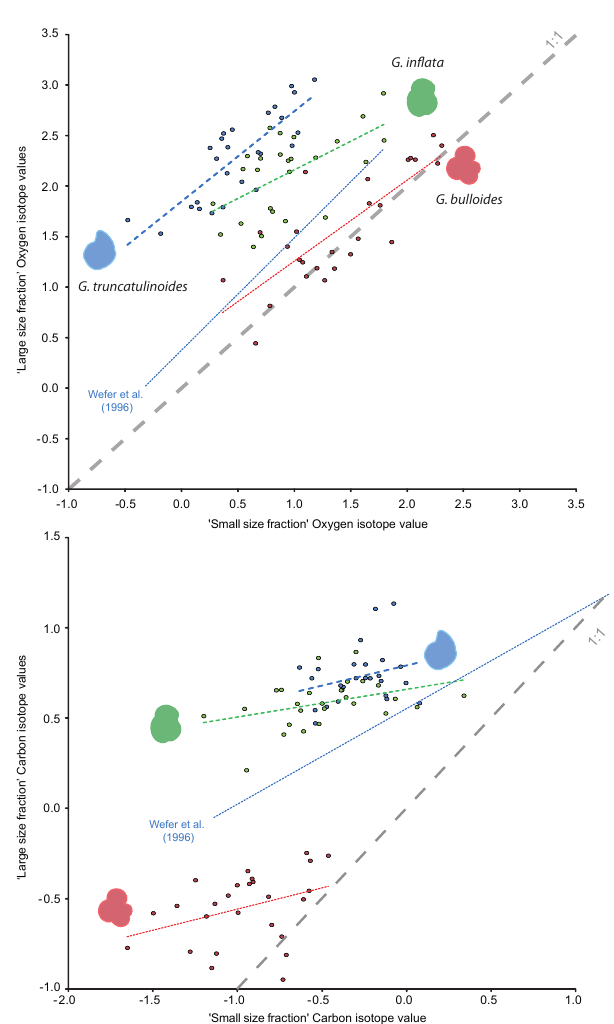
Figure 6. Isotope differences for each species between the smallest and largest size fraction. Isotope difference between the mean of the smallest (212–250µm) and largest (355–400µm) size fractions of (top panel) δ 18 O and (bottom panel) δ 13 C. The 1 : 1 ( δ -iso line) relationship (grey dashed line) is presented to compare the linear regressions (coloured dashed lines). For the equations of each linear regression and the resultant t -test values, see Table 4. The δ -iso lines of G. truncatulinoides from Wefer et al. (1996) are presented for